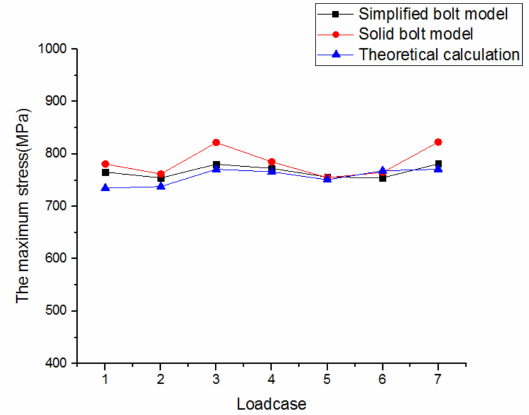
Figure 8. The maximum stress of bolts under extreme